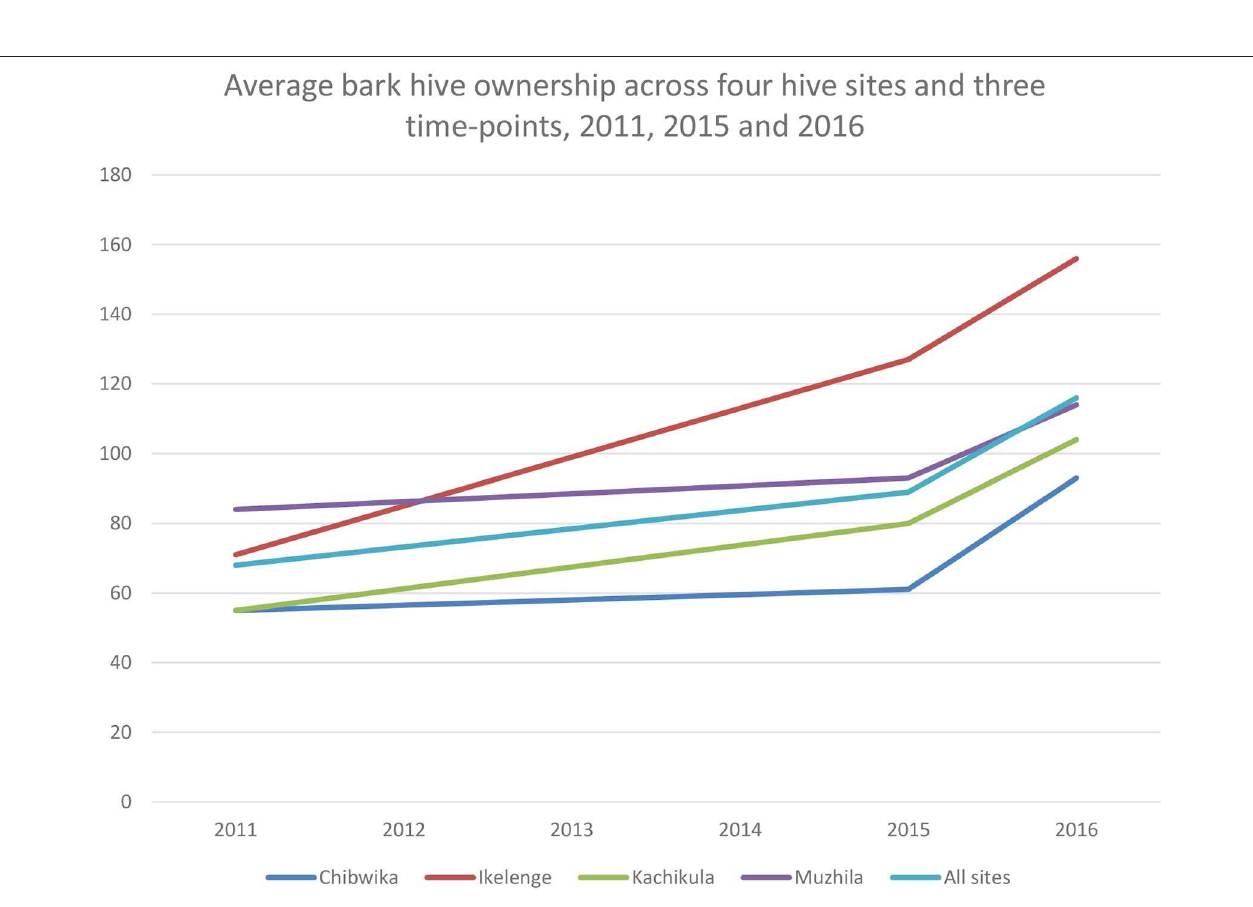
Frontiers in Forests and Global Change |